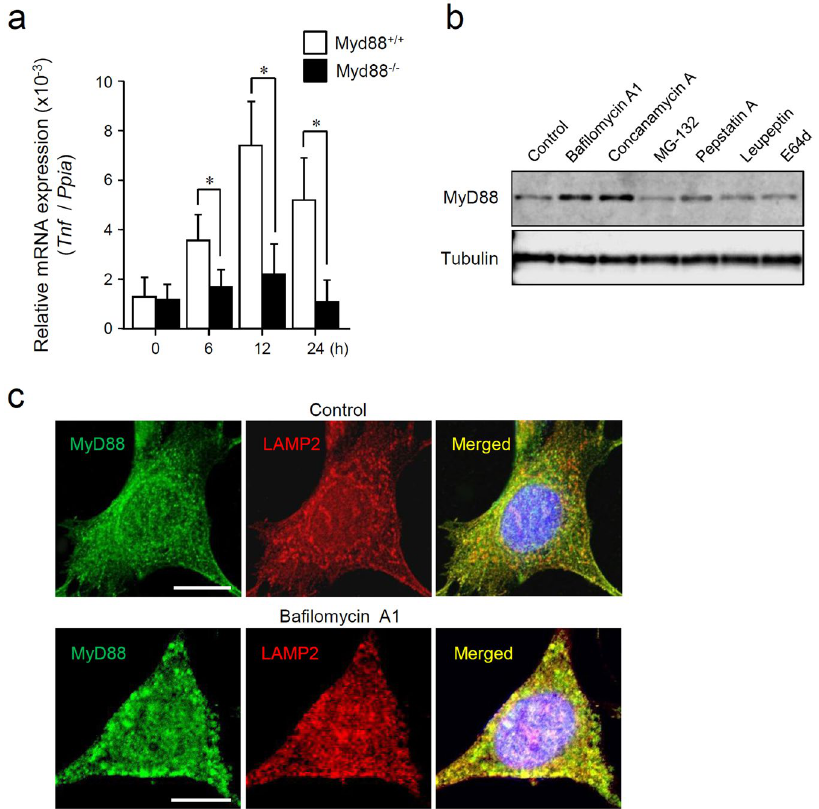
Figure 2. Lysosomal inhibition induces activation of MyD88-dependent inflammatory signals and accumulation of MyD88. ( a ) Deficiency of MyD88 impairs BafA1 treatment-induced Tnf expression. BMDMs collected from Myd88 + / + mice and Myd88 − / − mice were incubated with 100 nM BafA1 for the indicated periods, followed by RNA extraction. Relative expression levels of Tnf were determined by qRT-PCR. Each value is expressed as mean ± SD (n = 3); * p < 0.05 (Myd88 + / + versus Myd88 − / − ), one-way ANOVA and Dunnett’s test for post-hoc comparisons ( μ c ≠ μ i). ( b ) Treatment with the inhibitors of lysosomal functions or lysosomal proteases increases basal MyD88 expression. Mouse BMDMs were incubated with 0.5% DMSO (control), 100 nM BafA1, 100 nM concanamycin A, 20 μ M MG-132, 2 μ M pepstatin A, 50 μ M leupeptin, or 50 μ M E-64-d for 12 h. Expression levels of MyD88 and α -tubulin were assessed by immunoblotting. All the blots were obtained under the same experimental conditions, and the cropped images of the blots are shown. The uncropped images are in Supplementary Fig. 18. ( c ) BafA1 treatment causes accumulation of MyD88. Mouse BMDMs were incubated with 0.5% DMSO (control) or 100 nM BafA1 for 6 h. The cells were fixed, and immunofluorescent staining for MyD88 (green) and LAMP2 (red) was carried out. Cell nuclei were stained with Hoechst 33342. Images were acquired by means of a confocal microscope. Scale bar: 10 μ